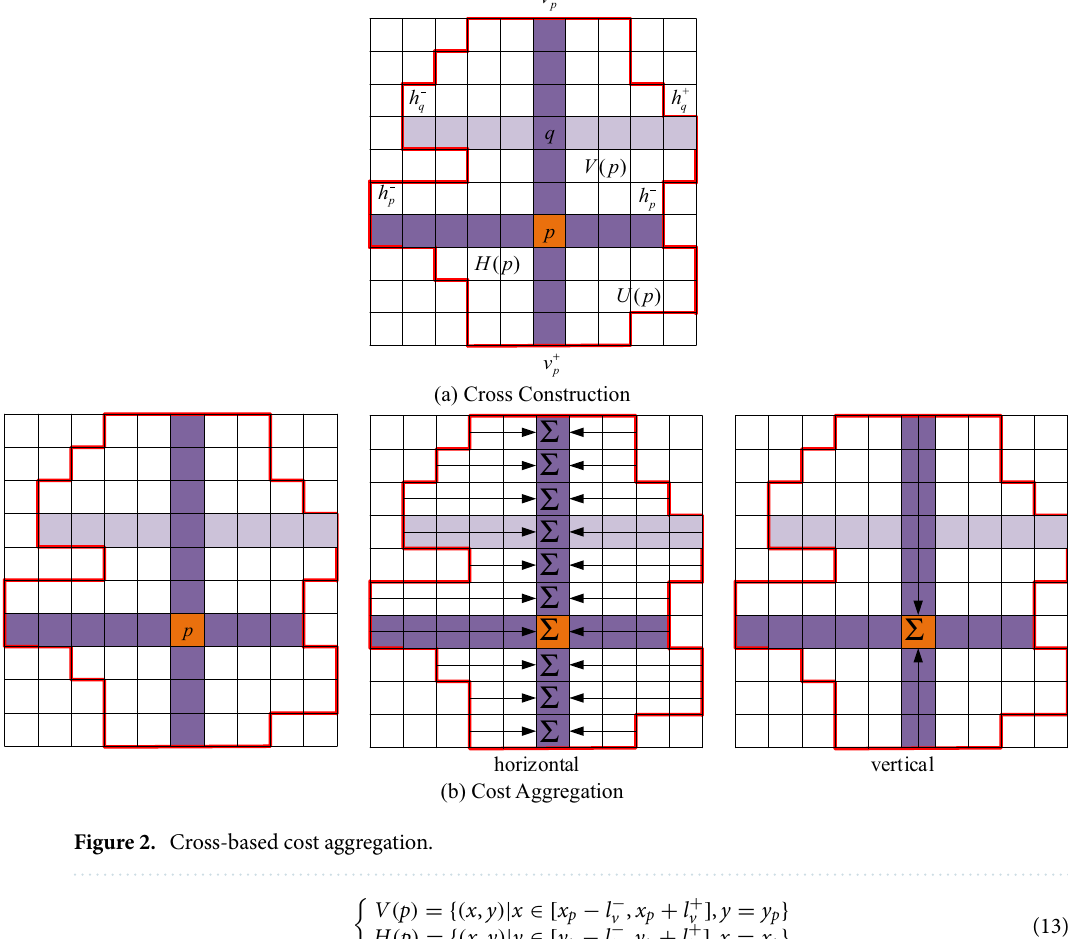
Figure 2. Cross-based cost